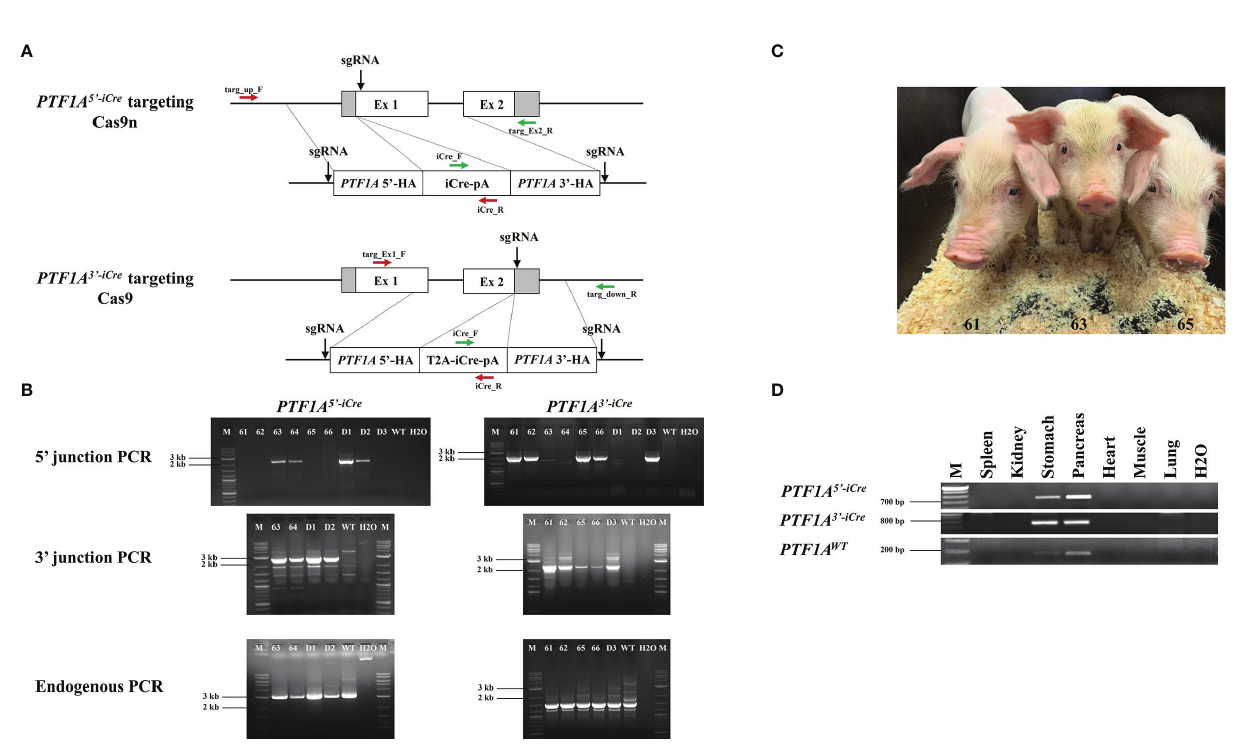
FIGURE 1 | Generation of PTF1A-iCre founder pigs. (A) Genome editing strategy for iCre insertion into the 5 ’ or 3 ’ end of the porcine PTF1A gene, using either Cas9 nickase (Cas9n) or conventional Cas9. Primer positions for targeting PCR across the 5 ’ and 3 ’ junctions are indicated as red and green arrows and for the non- targeted allele, the following primers were used: targ_up_F/targ_Ex2_R for PTF1A 5 ’ iCre and targ_Ex1_F/targ_down_R for PTF1A 3 ’ iCre pigs. (B) PCR analysis of 6 viable (61-66) and 3 dead (D1-D3) cloned piglets. Left panel: PTF1A 5 ’ iCre targeting PCRs. Ampli fi ed product for 5 ’ junction, 2233 bp; 3 ’ junction, 2346 bp; non- targeted allele, 3020 bp. Right panel: PTF1A 3 ’ iCre targeting PCRs. Ampli fi ed product for 5 ’ junction, 2127 bp; 3 ’ junction, 2300 bp; non-targeted allele, 2887 bp. Wild-type DNA was used as a control. M: Size marker. (C) Five weeks old PTF1A 5 ’ iCre (Pig_Id. 63) and PTF1A 3 ’ iCre (Pig_Ids. 61 and 65) piglets (D) RT-PCR analysis of PTF1A-iCre expression in different organs collected from the newborn founder